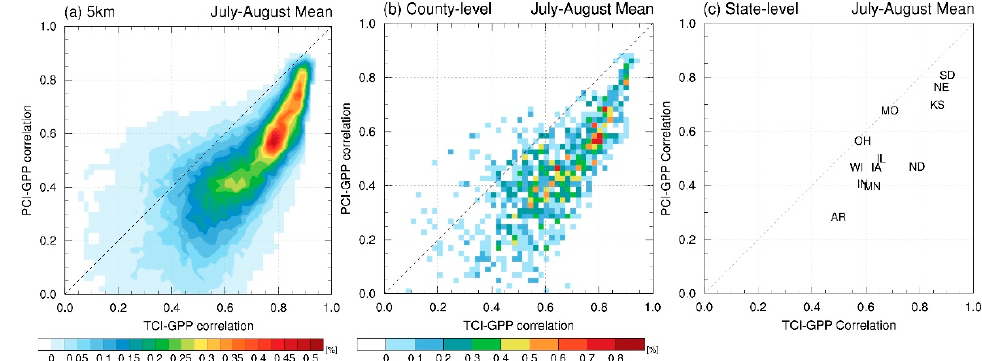
Figure 4 . Joint histogram of TCI-GPP relationship (x-axis) and PCI-GPP relationship (y-axis) at ( a ) satellite-, ( b ) county-, and ( c ) state-level data for the average of July and August. In ( a , b ), the x and y axes are separated by a 0.02 interval for each bin.